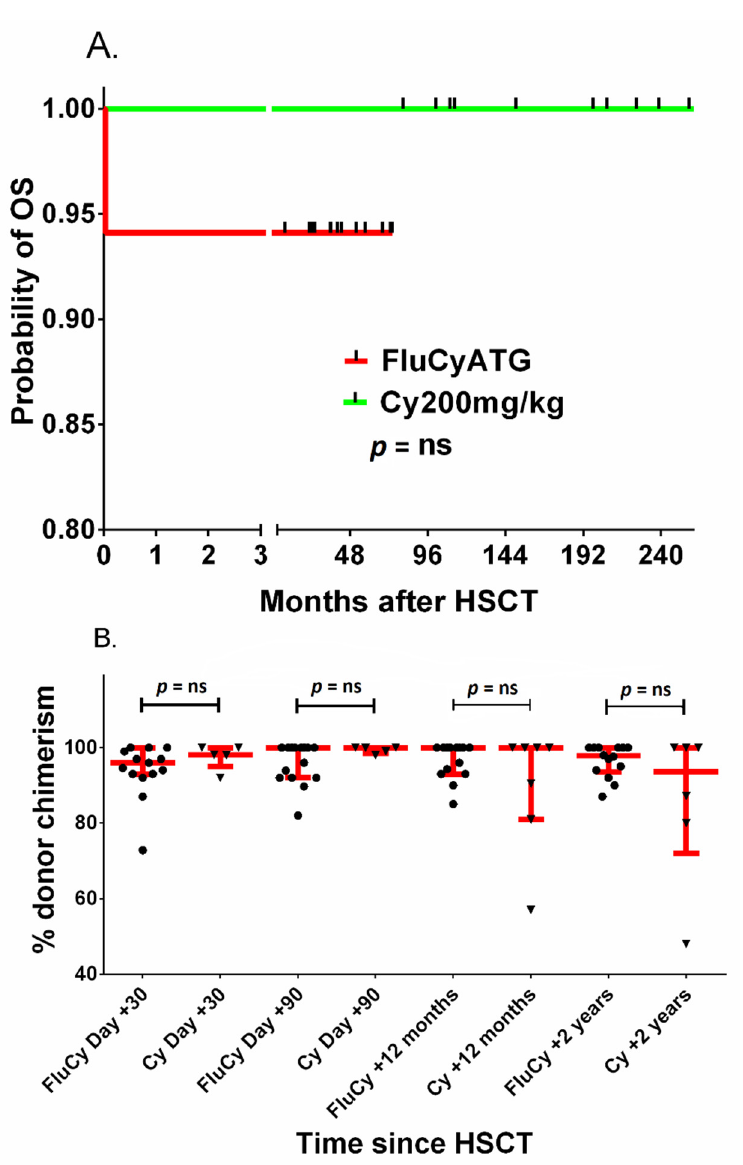
Figure 4. Probability of OS ( A ) and donor chimerism ( B ) after HCT with fludarabine–cyclophosphamide–ATG (FluCyATG) or cyclophosphamide 200 mg/kg BW. Red lines in figure ( B ) represent the median with interquartile range. Legend. OS, overall survival; GFS, graft versus host disease-free survival; HSCT/HCT, Allogeneic hematopoietic cell transplantation; Flu, fludarabine; Cy, cyclophosphamide; GVHD, graft versus host disease; aGVHD, acute graft versus host disease; cGVHD, chronic graft versus host disease ATG, antithymocyte globulin. Posttransplantation viral replications were observed in 33/56 patients (58.9%). ADV